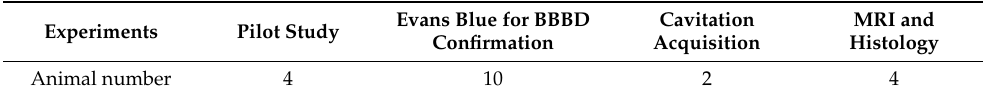
Table 1. Summary of Animal